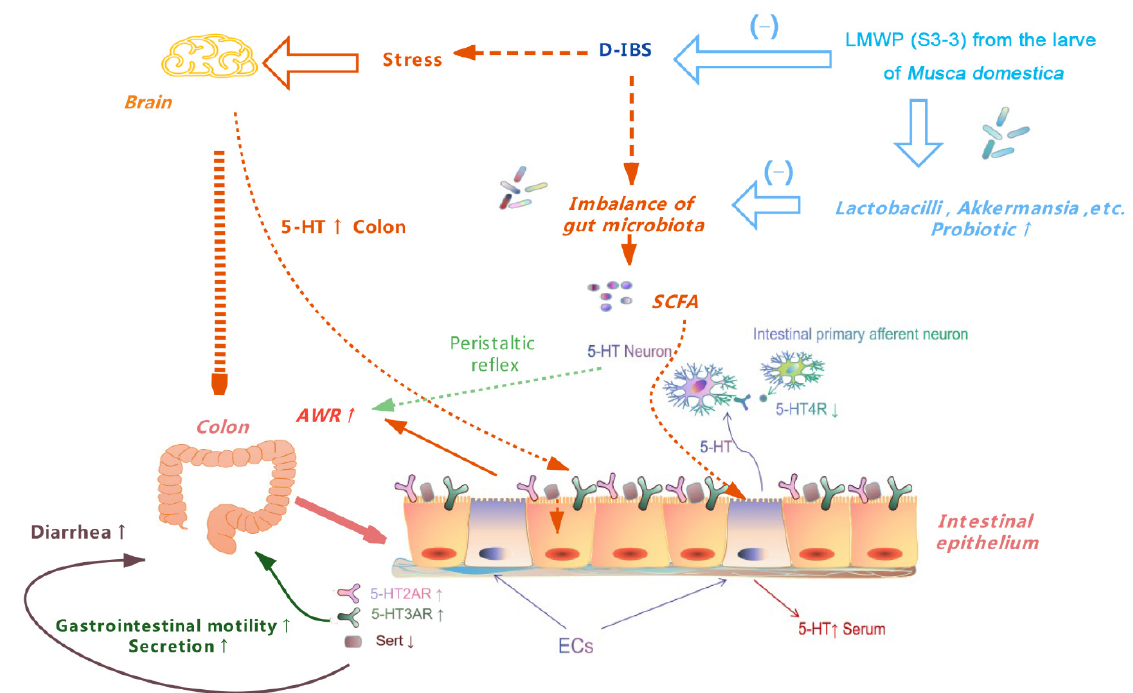
Figure 13. A schematic presentation of the therapeutic effect of LMWP (S3-3) from the larvae of Musca domestica on D-IBS.